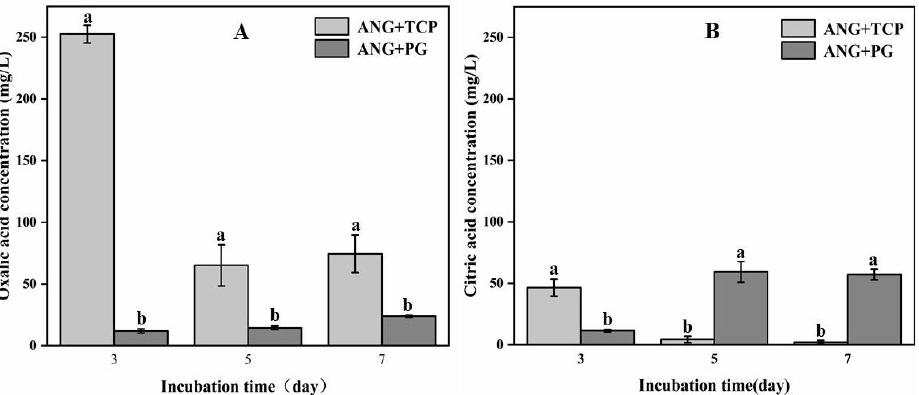
Figure 3. The secretion of oxalic acid ( A ) and citric acid ( B ) by between ANG + TCP and ANG + PG treatments during the incubation (3, 5, 7 days). The different lower-case letters indicate a significant difference between the treatments ( p < 0.05). The significant differences among the treatments were identified by the Tukey test ( p < 0.05).